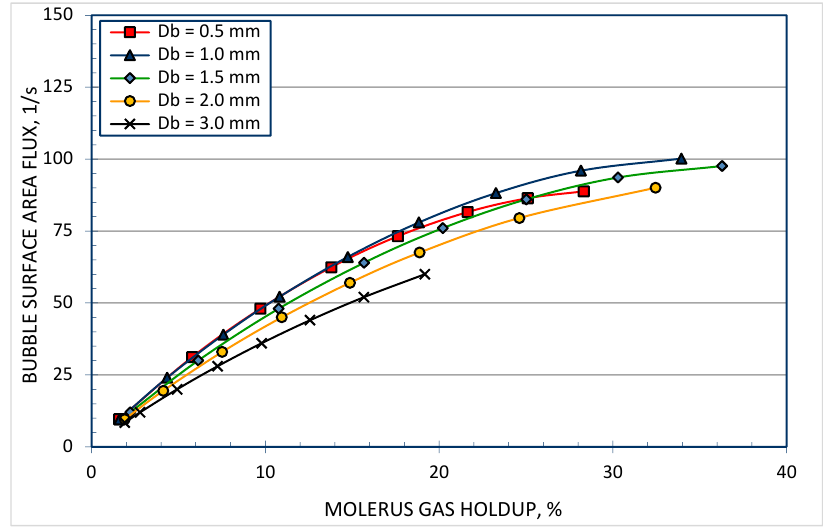
Figure 6. Bubble surface area flux vs. gas holdup prediction (Molerus model).